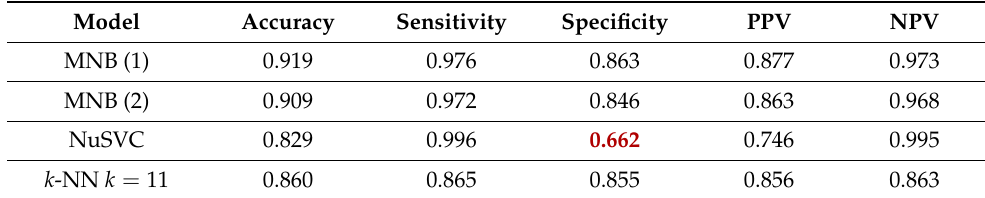
Table 16. Evaluation of the classifiers performance in Substage 4.